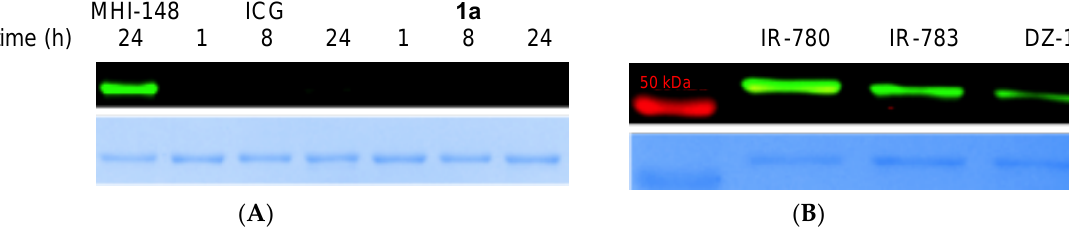
Figure 3. Near-infrared (NIR) fluorescent gel image of ( A ) vimentin (1 µ M) incubated with different cyanines (10 µ M) in 50 mM pH 7.24 HEPES buffer at different incubation times; ( B ) vimentin (1 µ M) incubated with IR-780, IR-783, and DZ-1 in the same buffer as ( A ) for 24 h. CBB-G250 staining indicated an equal amount of protein (100 ng) was loaded into gel.